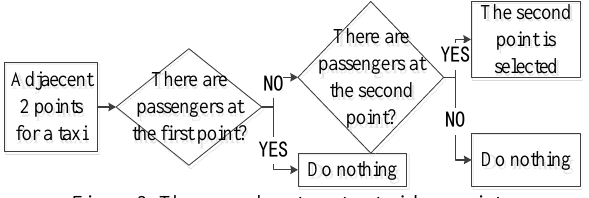
Figure 3. The procedure to extract pickup points.